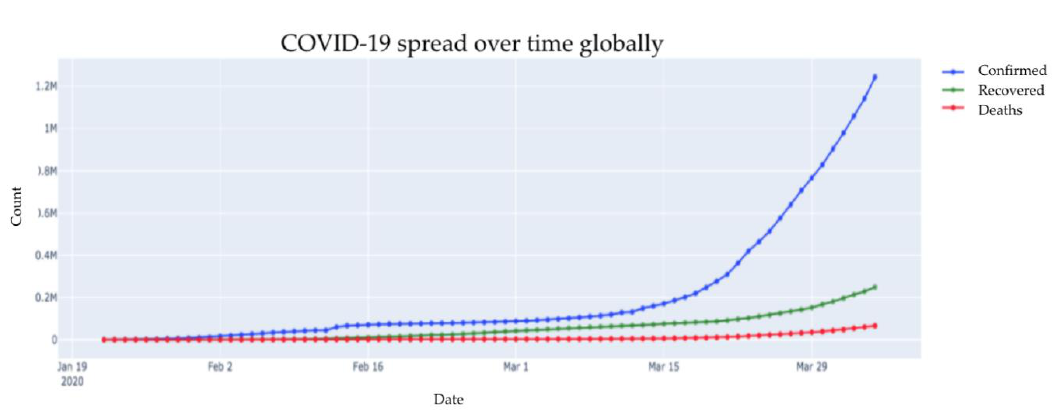
Figure 1. Outbreak of corona virus disease 2019 (COVID-19) across globe